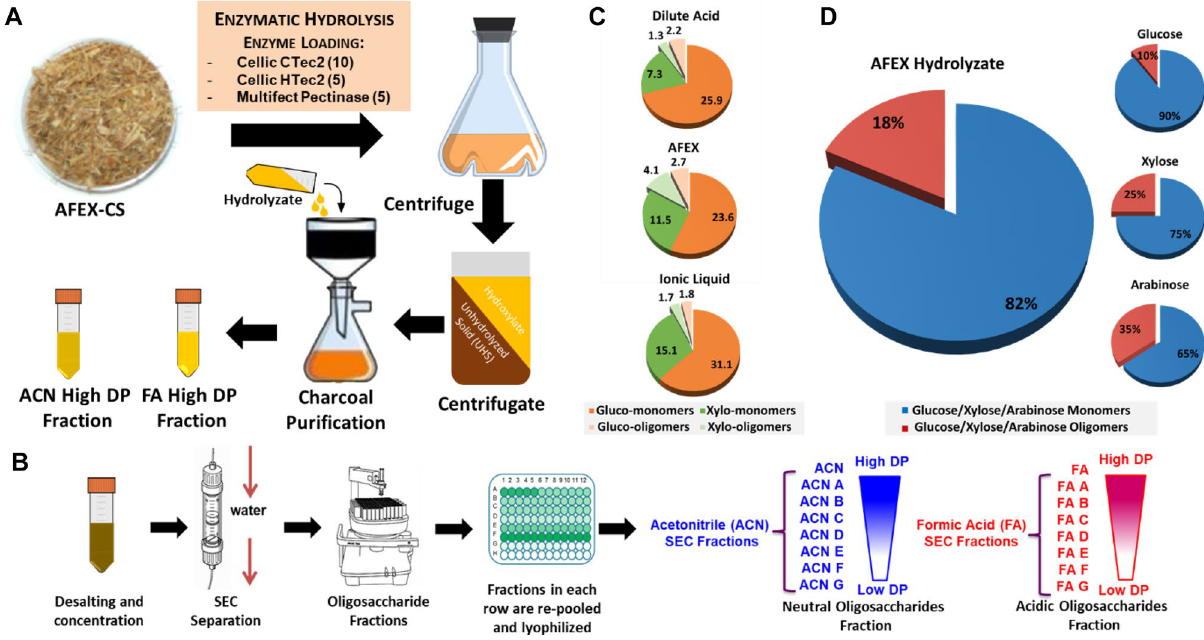
Figure 1. Recalcitrant oligosaccharides remained unhydrolyzed after pretreatment and enzymatic hydrolysis. Here, ( A ) Methodology of oligosaccharides separation where, oligosaccharides were separated from AFEX- pretreated corn stover Hydrolysate (ACSH) by activated charcoal and celite packed bed; ( B ) methodology of oligosaccharides separation. Oligosaccharides were further fractionated by size exclusion chromatography (SEC); ( C ) sugar monomers and oligomers released by different pretreatments (dilute acid: DA, ionic liquid: IL and AFEX). Enzymatic hydrolysis conditions: High solids loading 25% (w/w) (approximately to 8% glucan loading), 96 h hydrolysis, 20 mg/g commercial enzyme loading (Ctec2: Htec2: MP—2:1:1 ratio) and ( D ) Sugar monomers and oligomers of glucose, xylose and arabinose released by AFEX-pretreated corn stover